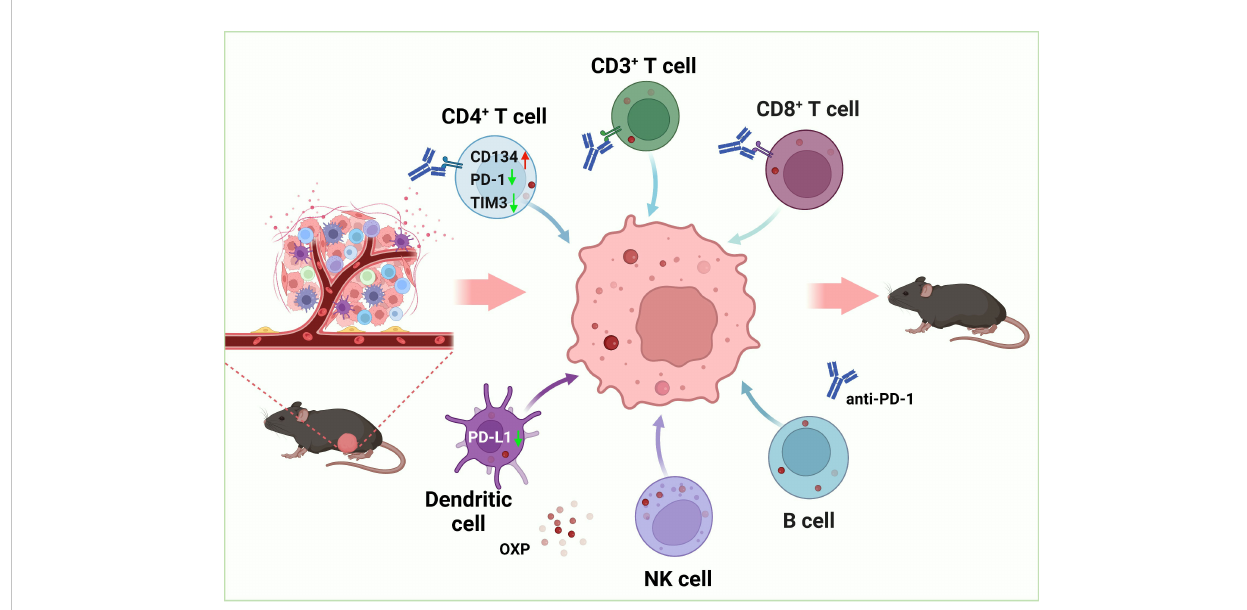
FIGURE 1 Schematic diagram of the therapeutic mechanism for combination of OXP and anti-PD-1 inhibitor in bladder cancer tumor immune